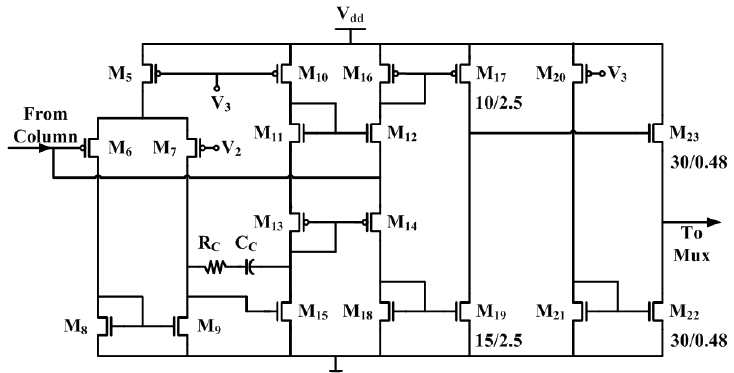
Figure 5. Circuit Schematic of the current conveyor